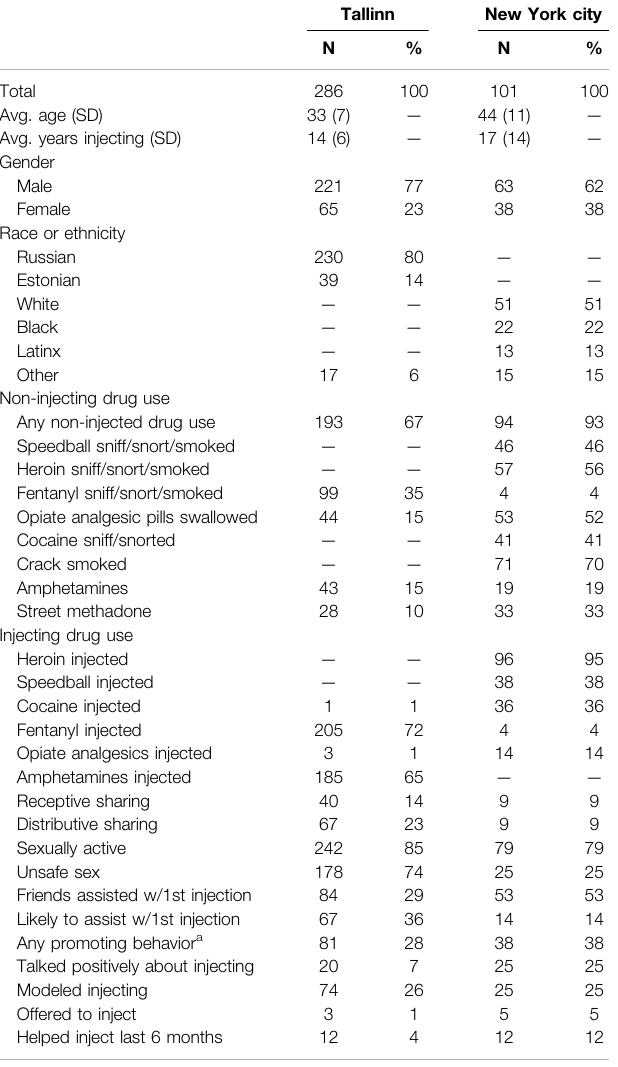
TABLE 1 | Demographics, drug use characteristics, and promoting behaviors among PWID in Tallinn and Staten Island, New York